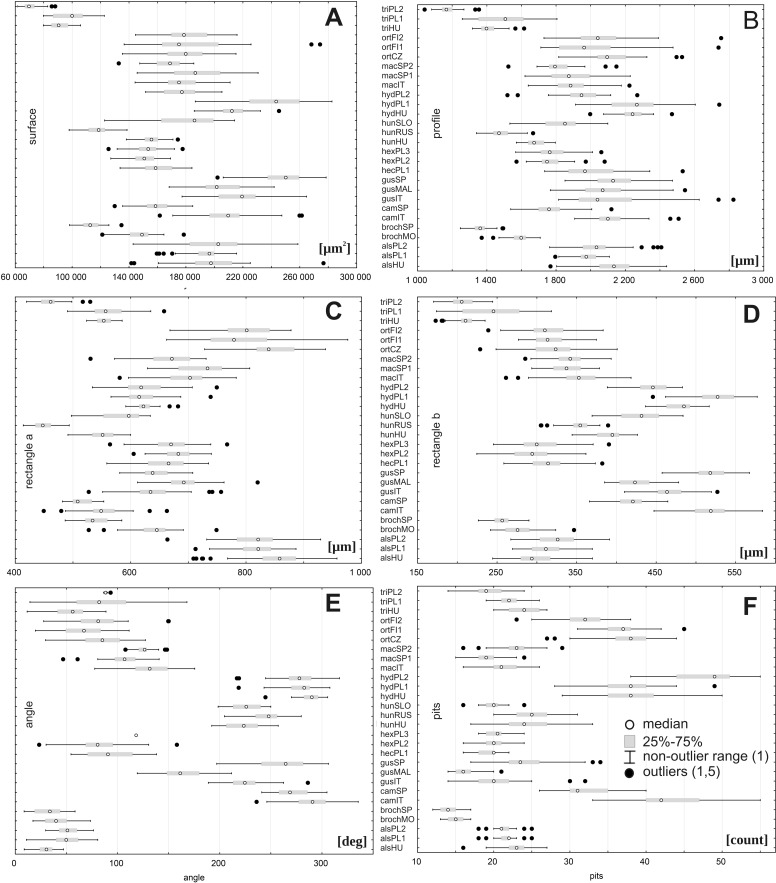
Boxplots of the most discriminative seed traits among 28 studied populations of Elatine.Notations: boxes indicate 25–75 percentiles, white point indicate medians, whiskers exclude outliers, black points indicate outliers. For acronyms, see Table 1. (A) surface; (B) profile; (C) rectangle a; (D) rectangle b; (E) angle; (F) pits.